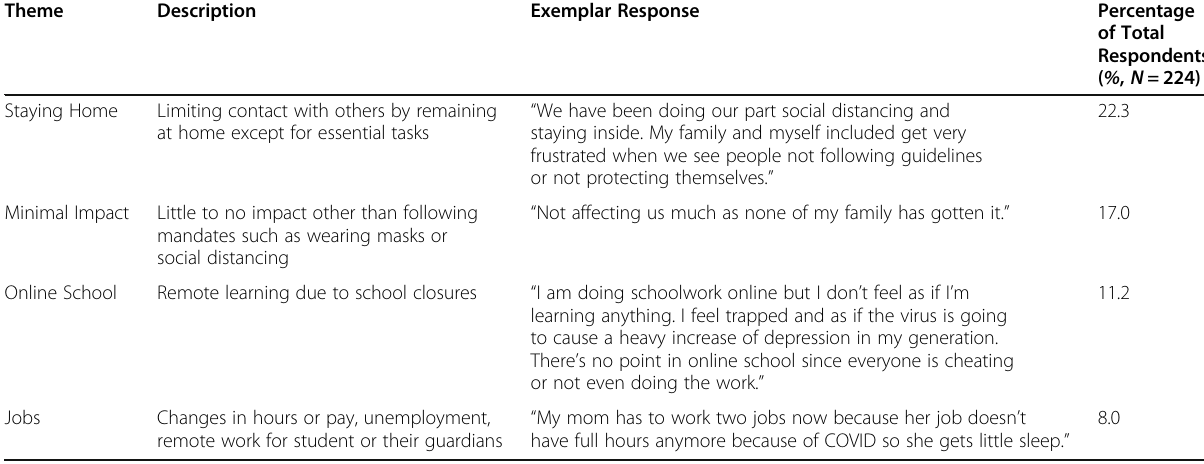
Table 4 Thematic Analysis of Student Impact Related to COVID-19